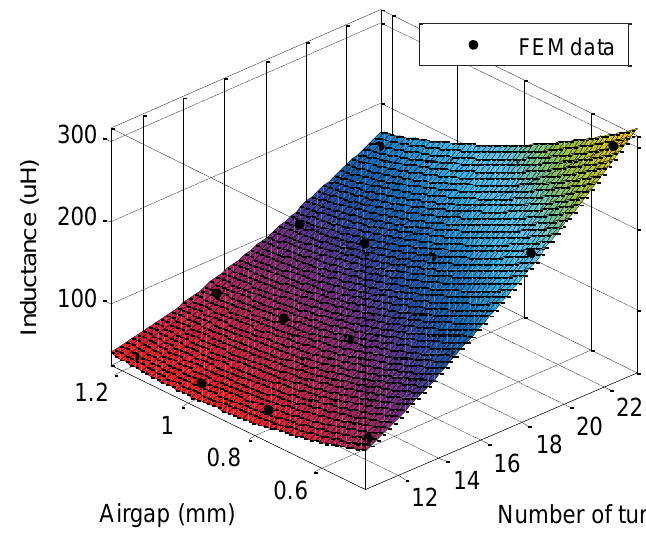
Figure 9. Inductance value in function of air-gap and number of turns.